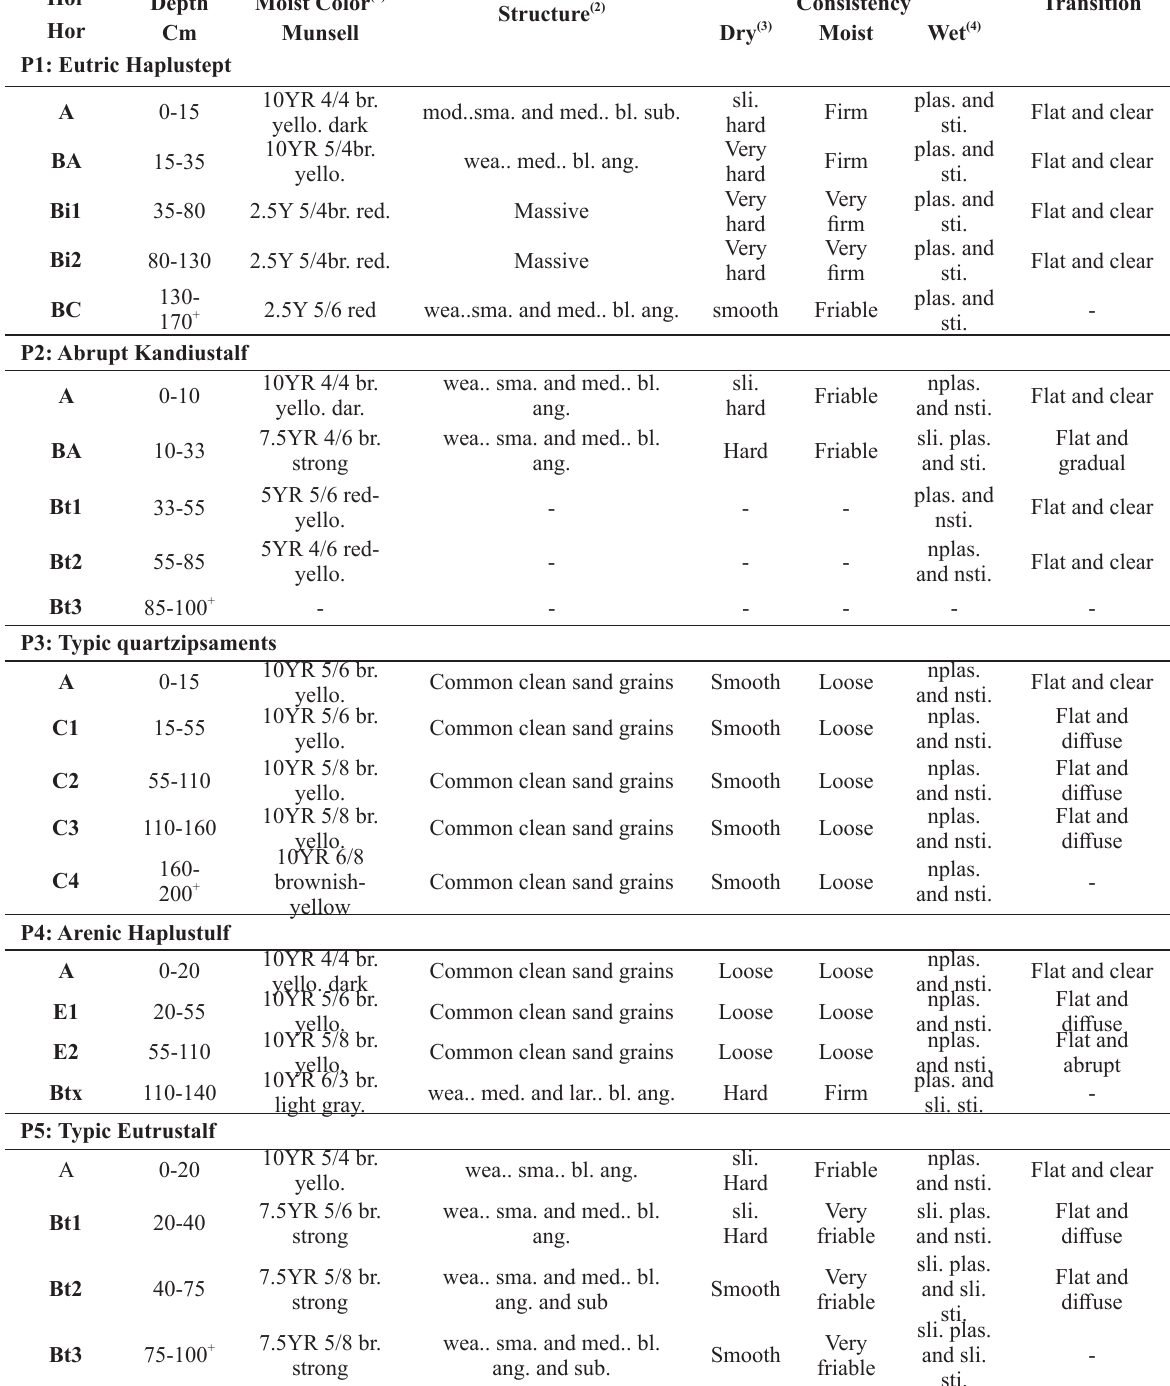
Morphological attributes of five representative soils classes.